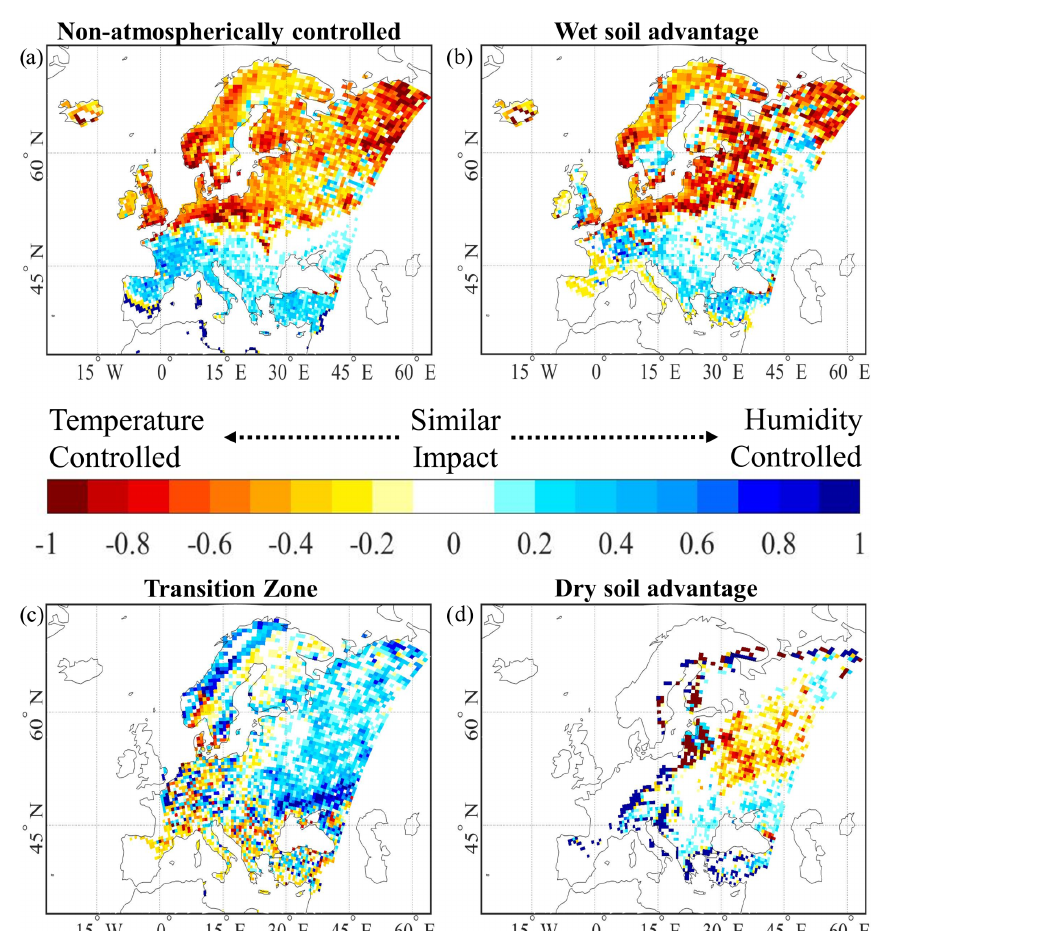
Figure 8. Sensitivity score of (a) non-atmospherically controlled days per summer season, (b) wet soil advantage days per summer season, (c) transition zone days per summer season and (d) dry soil advantage days per summer season to changes individual modifications in the air temperature profile ( − 1 indicates totally temperature controlled) and specific humidity profiles (1 indicates totally humidity